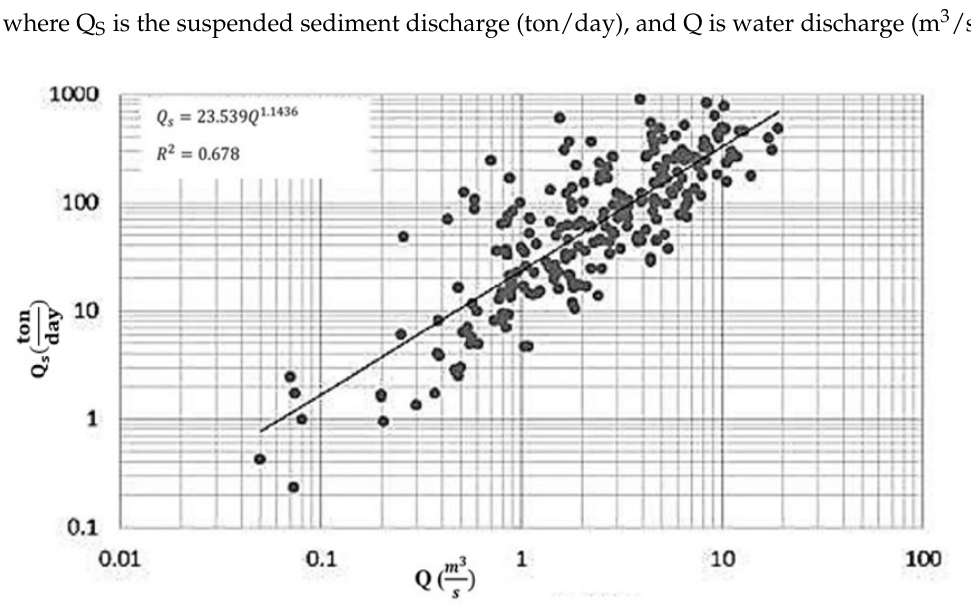
Figure 9. Sediment rating curve for Babolroud River.